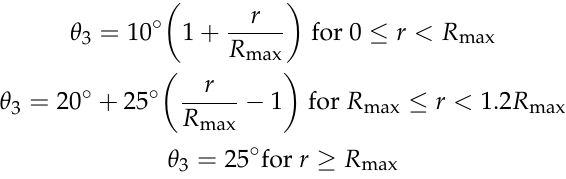
Table 1 lists the parameters used in SELFE-WWM-II and parametric cyclone